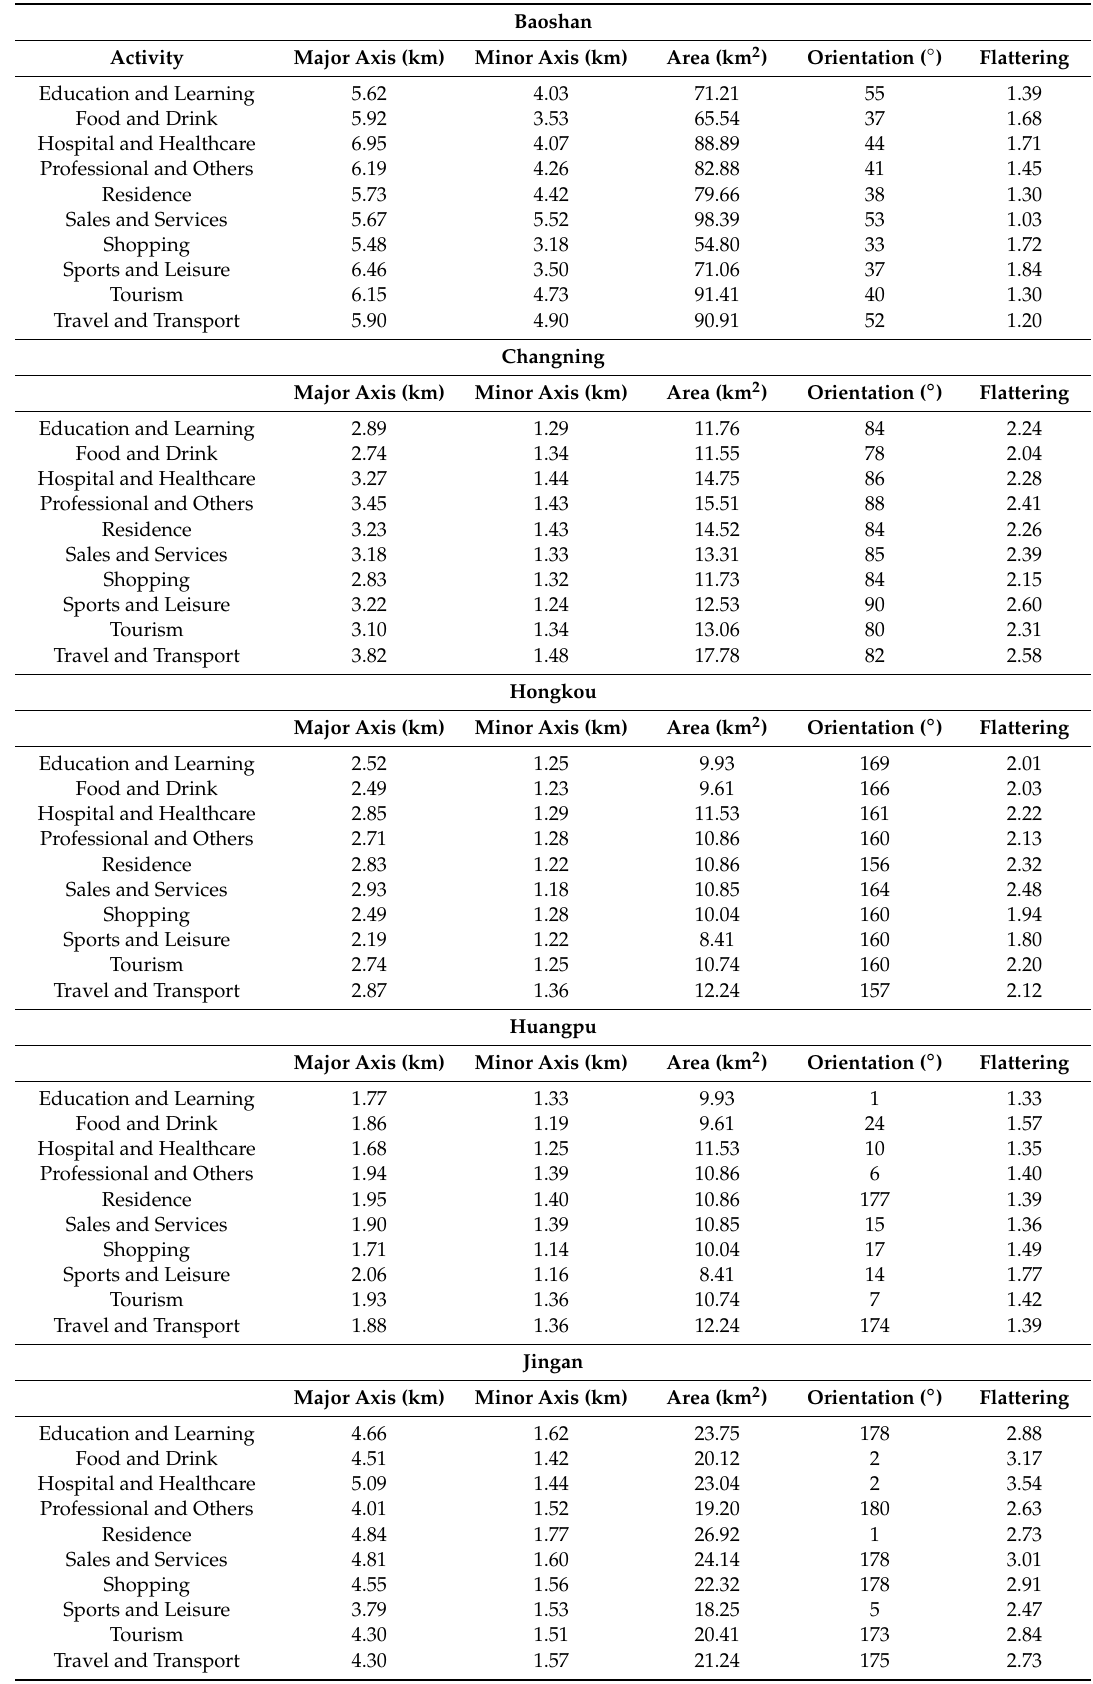
Table 7. SDE features on major and minor axes, area, azimuth, and flattering in districts of